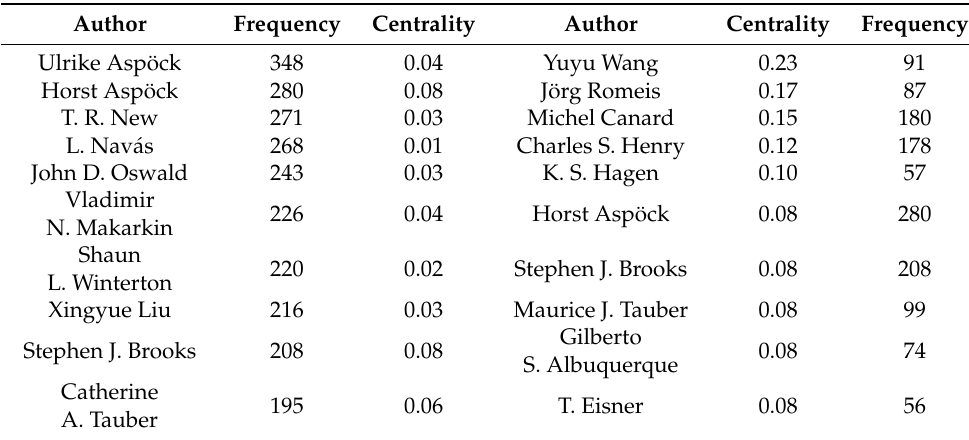
Figure 4. Author co-citation network. Each node stands for an author and each link depicts the interactions between authors. Node size represents the number of co-citations of the authors. Purple trims around some nodes indicate that those nodes received relatively high-centrality scores. Table 3. Top 10 authors in terms of frequency and centrality.